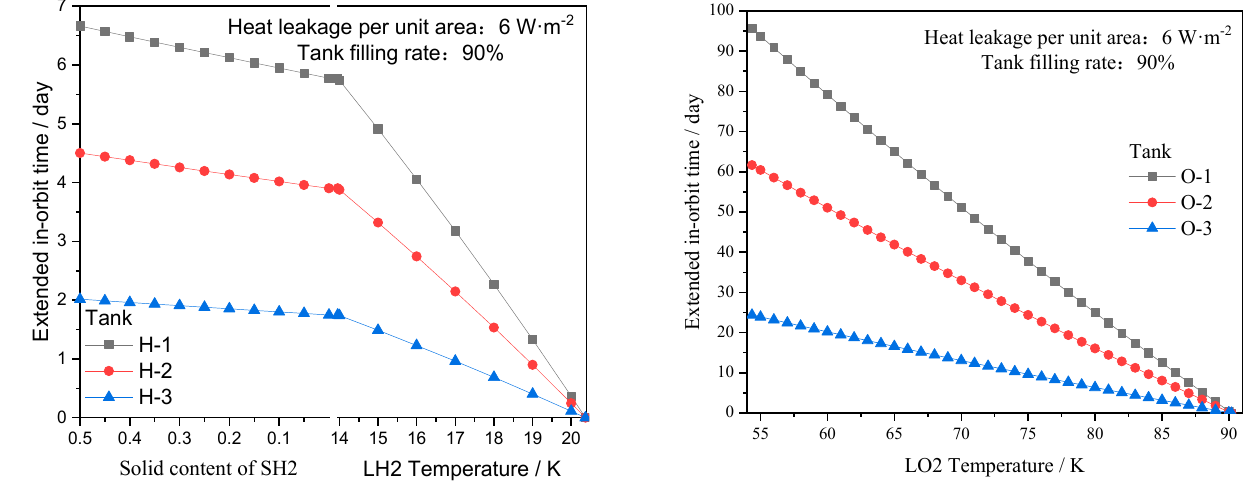
Figure 11. Relationship between LH2/LO2 densification degree and extended in-orbit time.